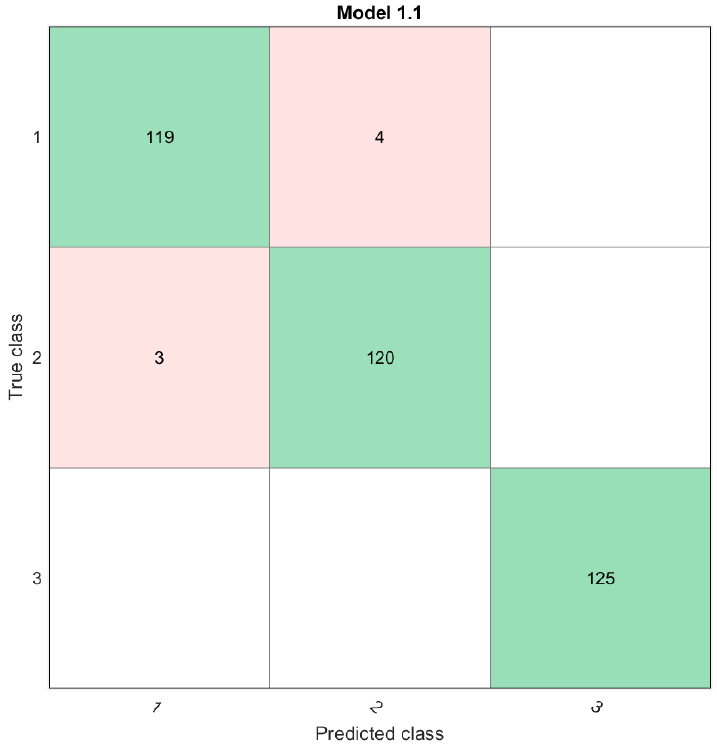
Figure 6. ROC curve for the model (1st group of data) .